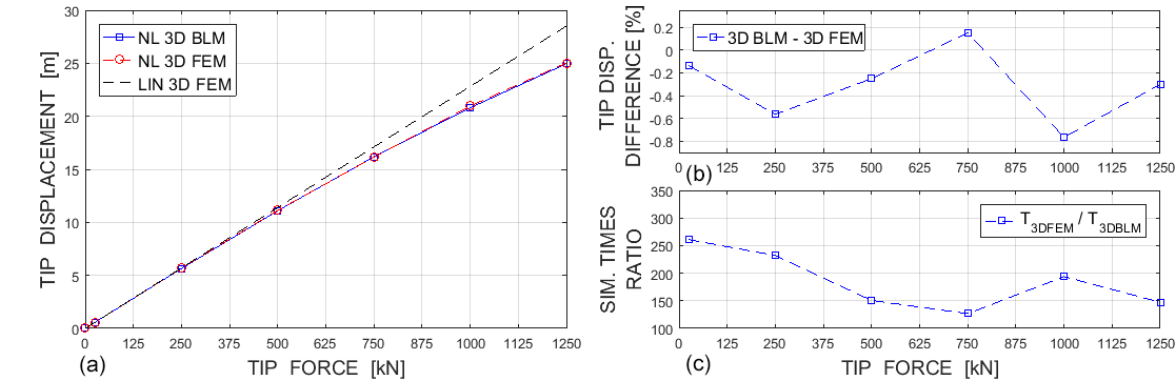
Figure 6. Comparison of tip displacements (a) , tip displacement differences (b) and simulation times ratio (c) .